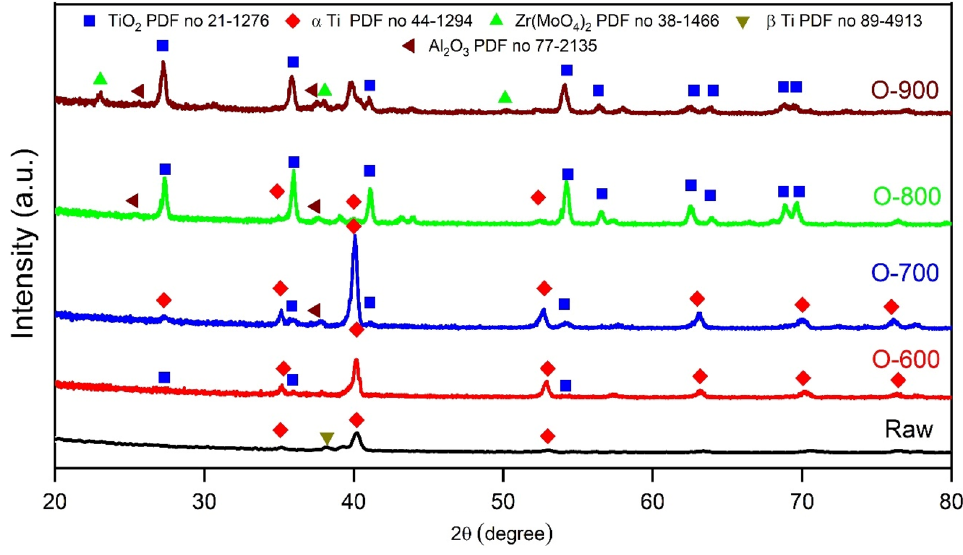
Figure 10. XRD of raw and oxidized specimens at a temperature of 600, 700, 800, and 900 °C for 50 h.